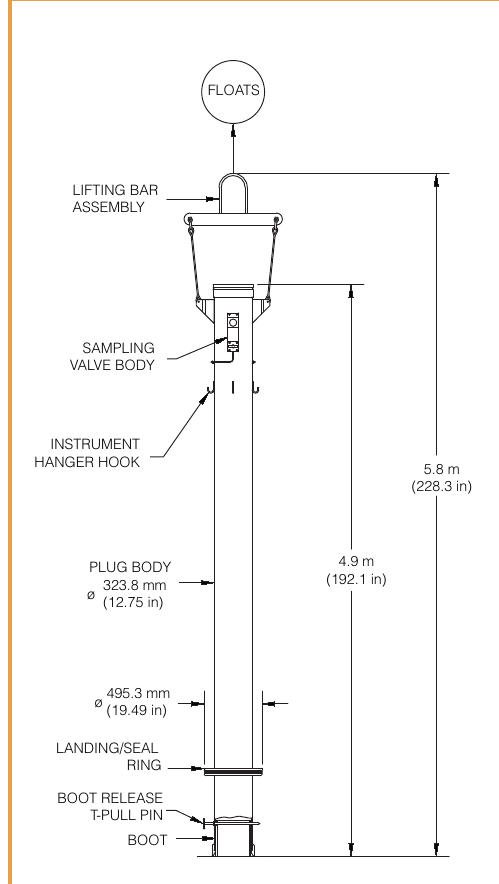
Figure 2. The CORK-Lite body is lowered over the side of the R/V Maria S. Merian . The boot is held in place with a tee handle and secured with a bungie. The lifting bar